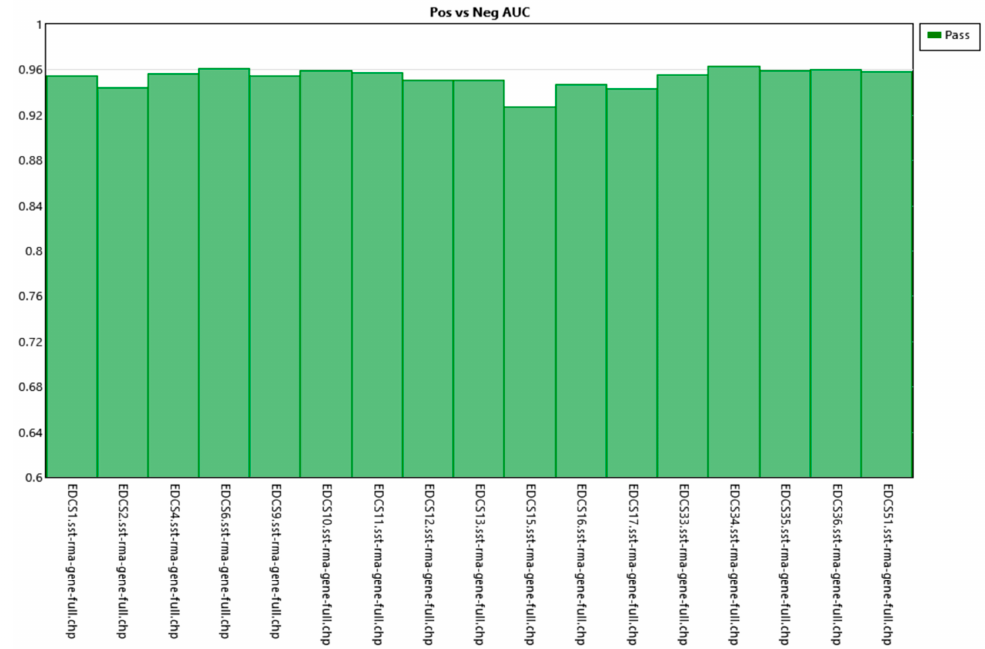
Figure 2. Positive vs. negative AUC. Shows the value of the samples analyzed. It can be seen that all are close to a value of 1, which shows that the samples behave correctly and homogeneously.